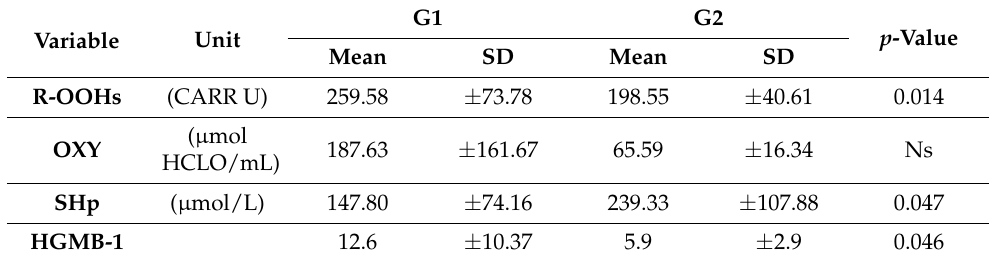
Table 3. R-OOHs, OXY, SHp, and HGMB-1 concentrations in G1 and G2 groups.